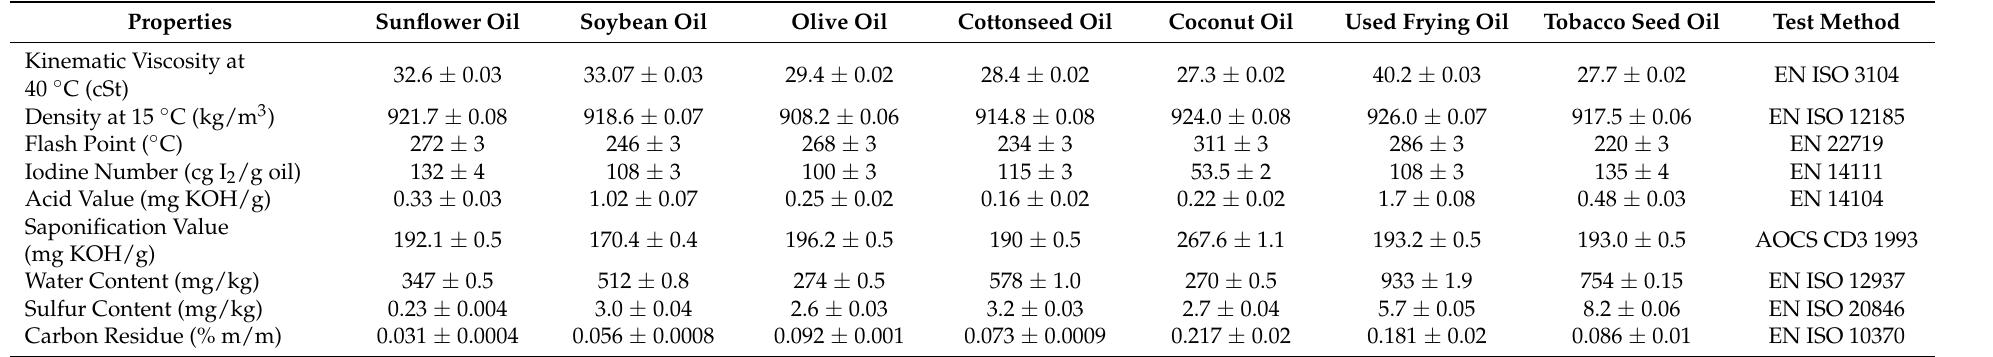
Table 1. Main properties of vegetable oils with relevant measurement uncertainties.